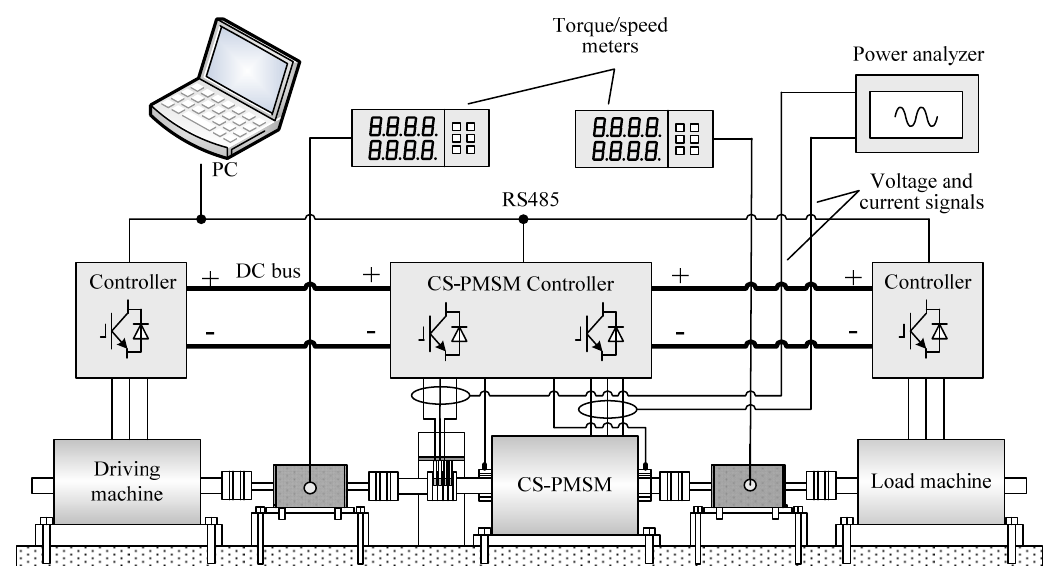
Figure 7. CS-PMSM test